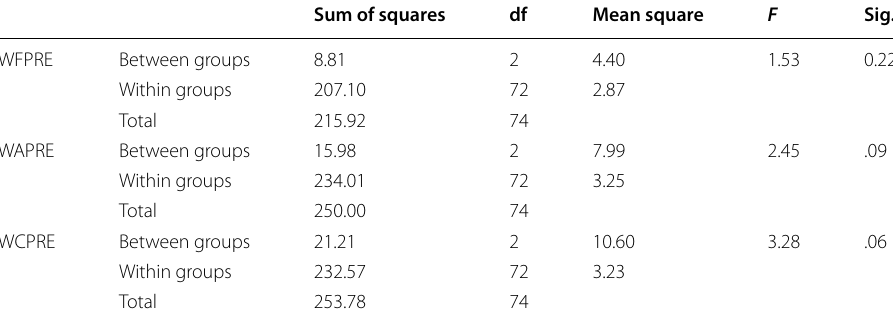
Table 7 Inferential statistics of all groups on the pretests of writing accuracy, fluency, and complexity